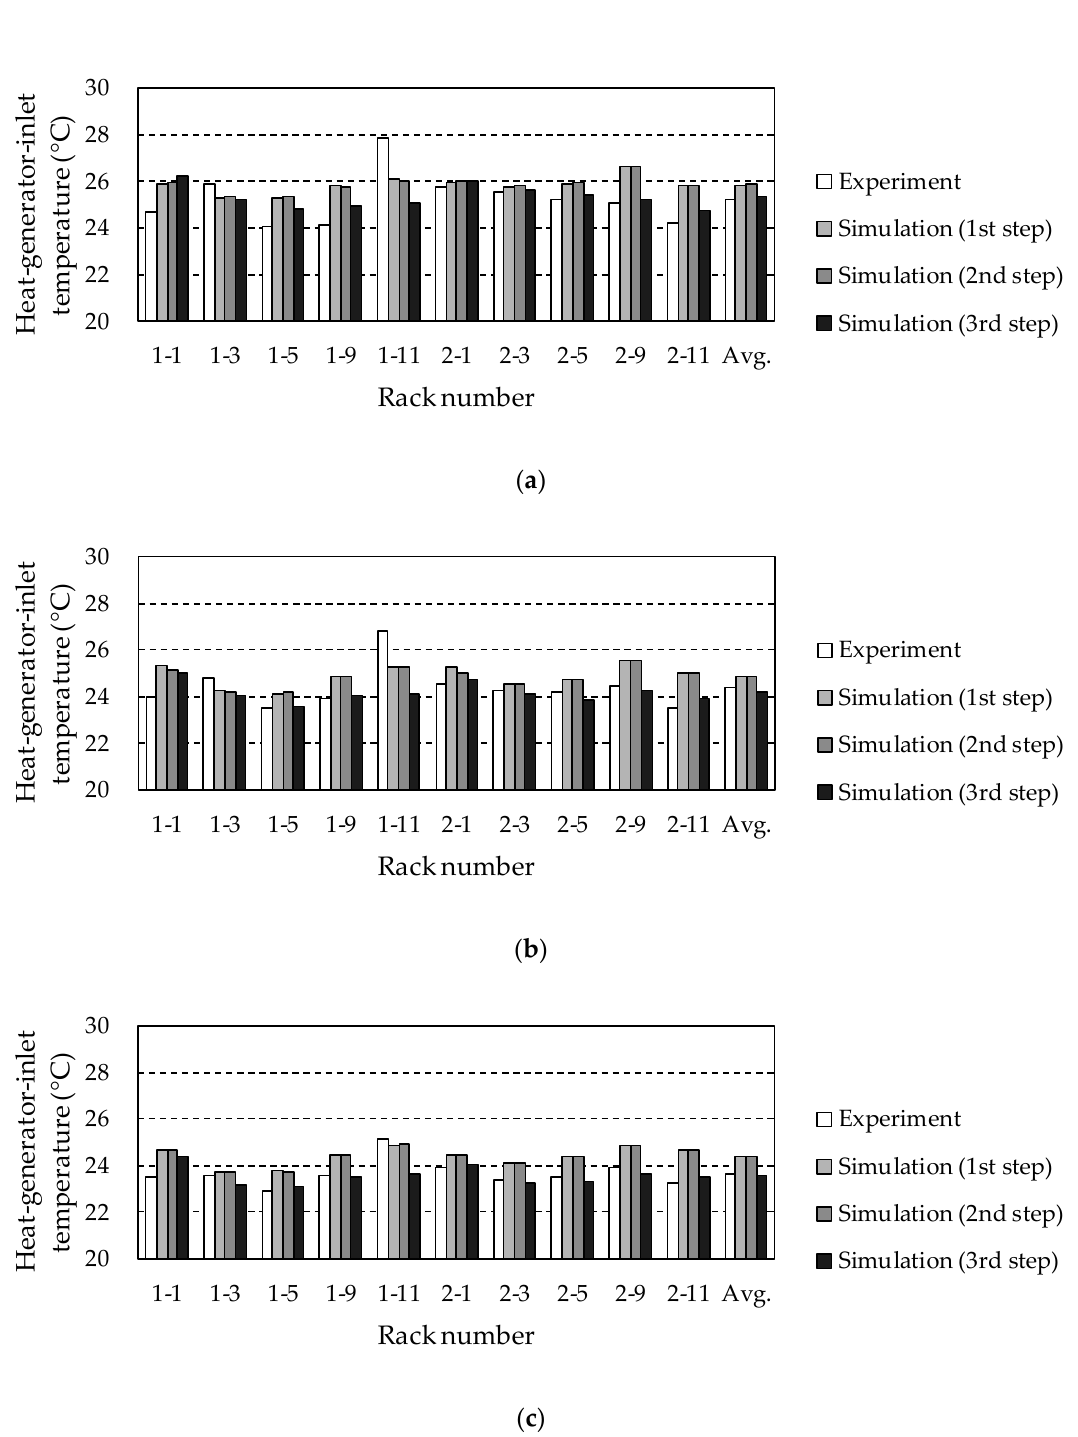
Figure 6. Prediction results for heat-generator inlet temperature at computer-room air-conditioning (CRAC) fan rotational speeds of ( a ) 45 Hz (G 1 ), ( b ) 54 Hz (G 2 ), and ( c ) 63 Hz (G 3 ).